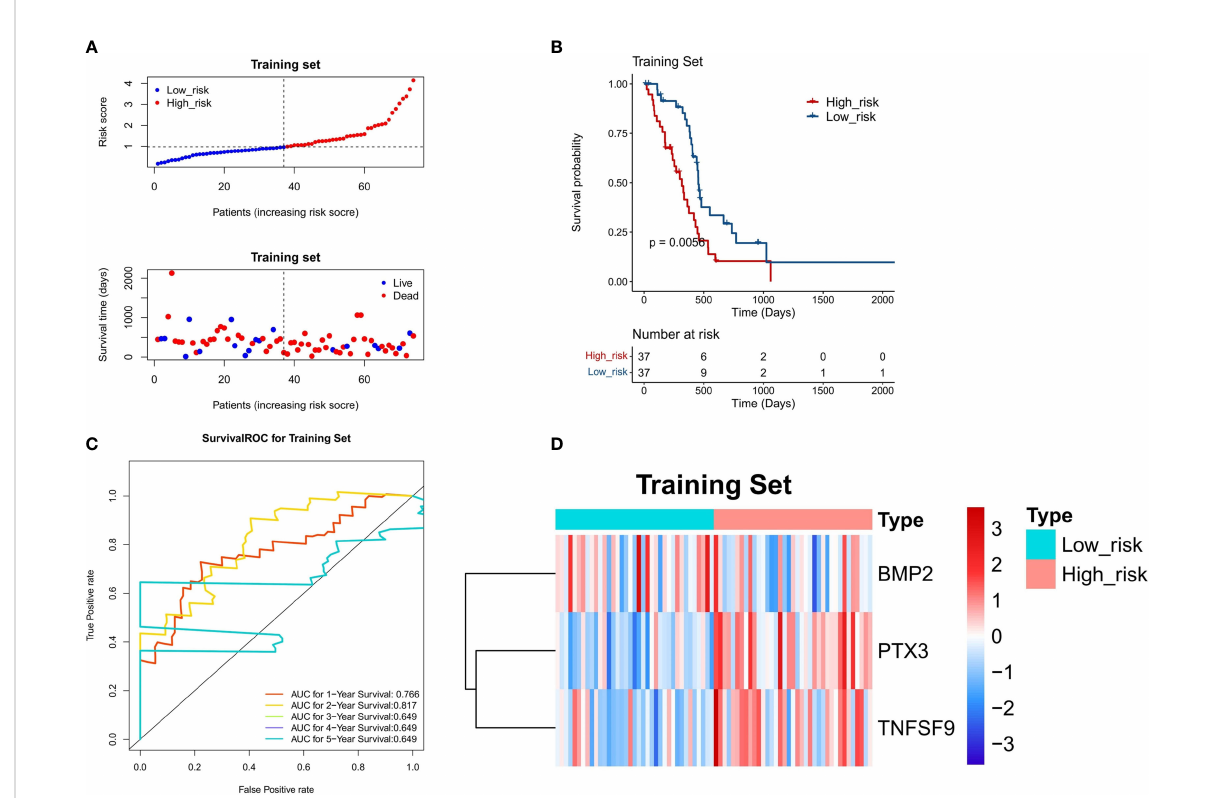
FIGURE 5 Evaluation of the DE-IRG signature-based risk model in the training set (n = 74). (A) The prognostic curve and a scatter plot for the training set. (B) The Kaplan – Meier OS curves of the high- and low-risk groups for the training set ( P = 0.0056). (C) ROC curve for the training set (AUC >0.6). (D) The heat map of the gene expression pro fi les of the three model genes in the training